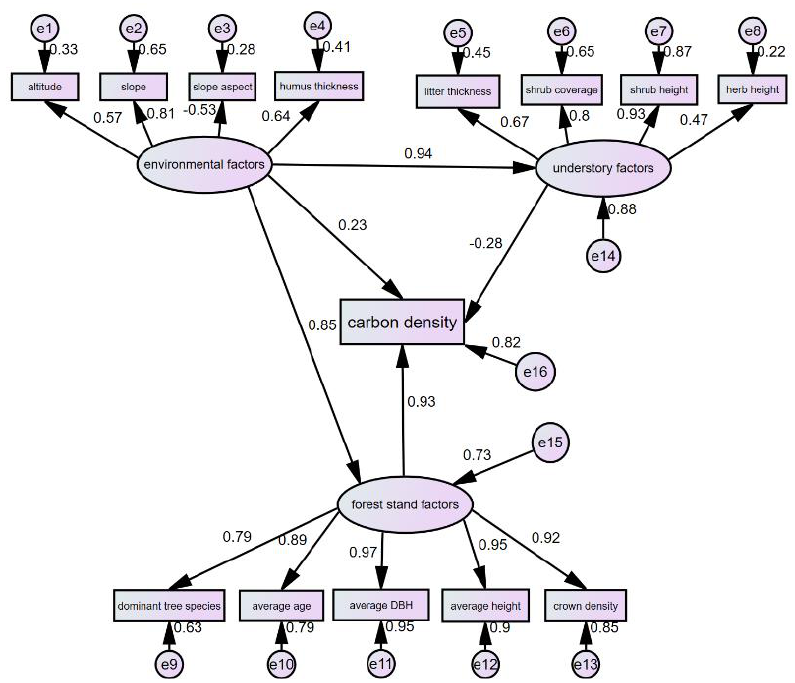
Figure 6. Structural equation model of carbon density in Guangdong Province.